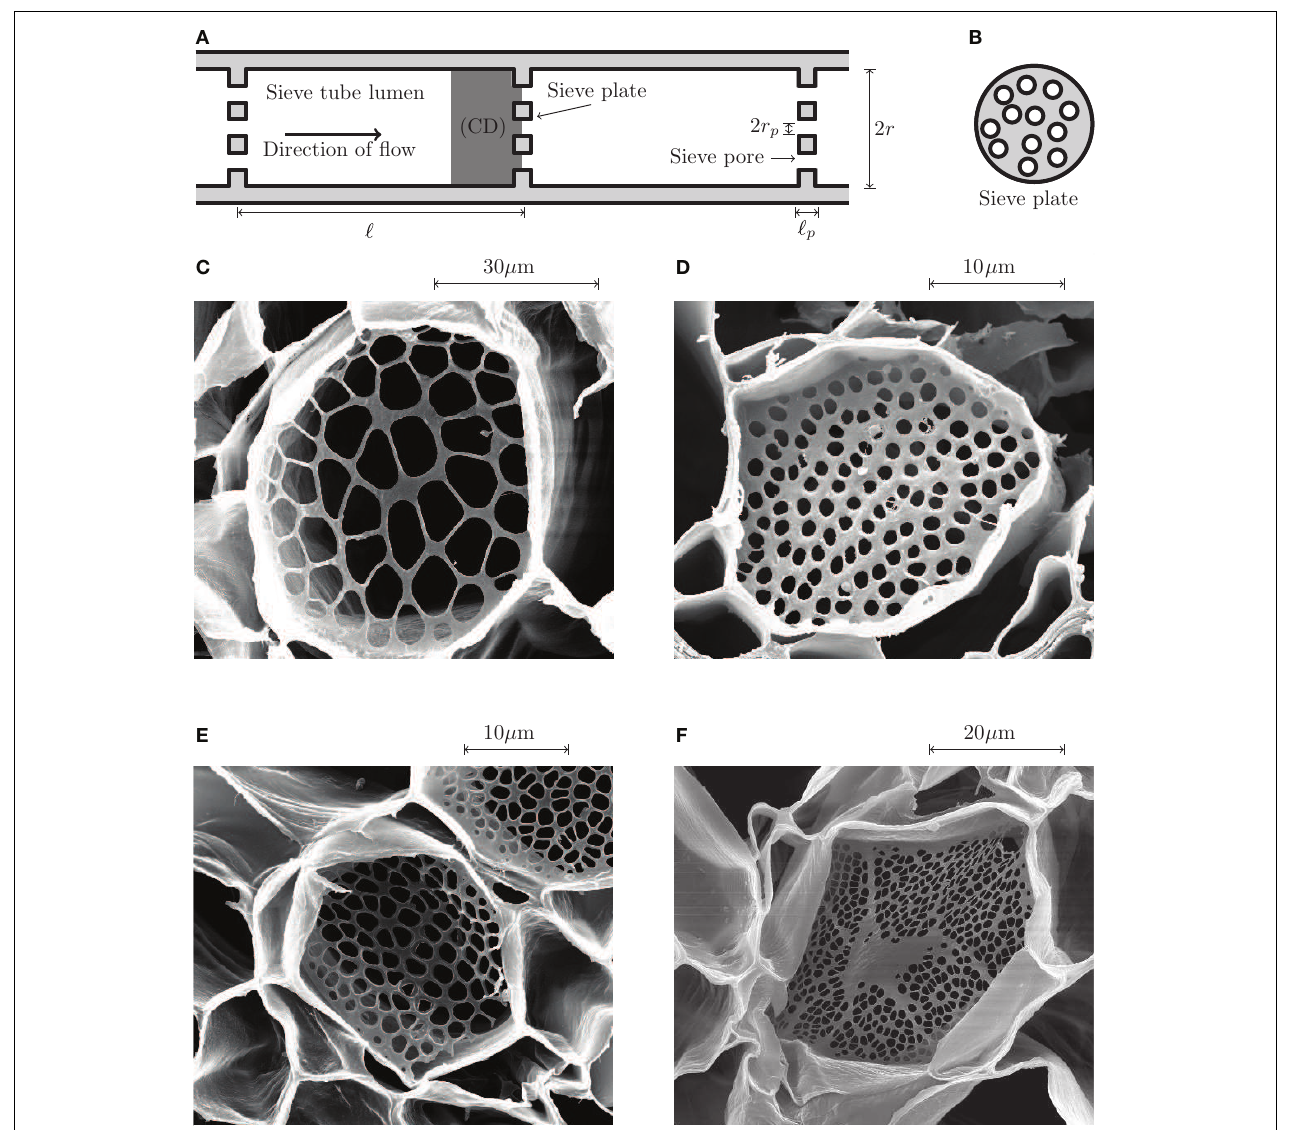
electron microscope (SEM) images of sieve plates. (C) Cucurbita maxima (Squash). (D) Phyllostachys nuda (Bamboo). (E) Phaseolus vulgaris (Green bean). (F) Ricinus communis (Castor bean). As shown in Figure 2 , the sieve pore radius r p is normally distributed with a standard deviation σ p